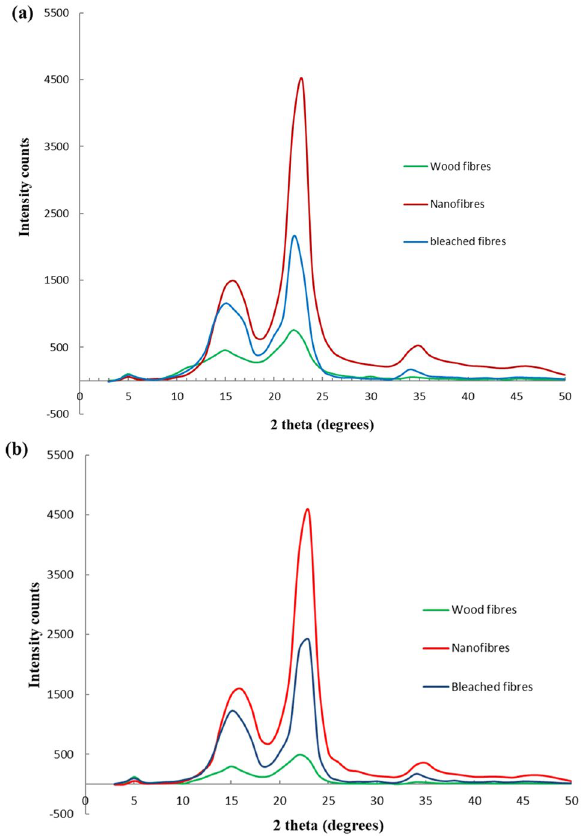
Figure 6. XRD spectra of untreated and treated samples of ( a ) Eucalyptus tereticornis and ( b ) Casuarina equisetifolia